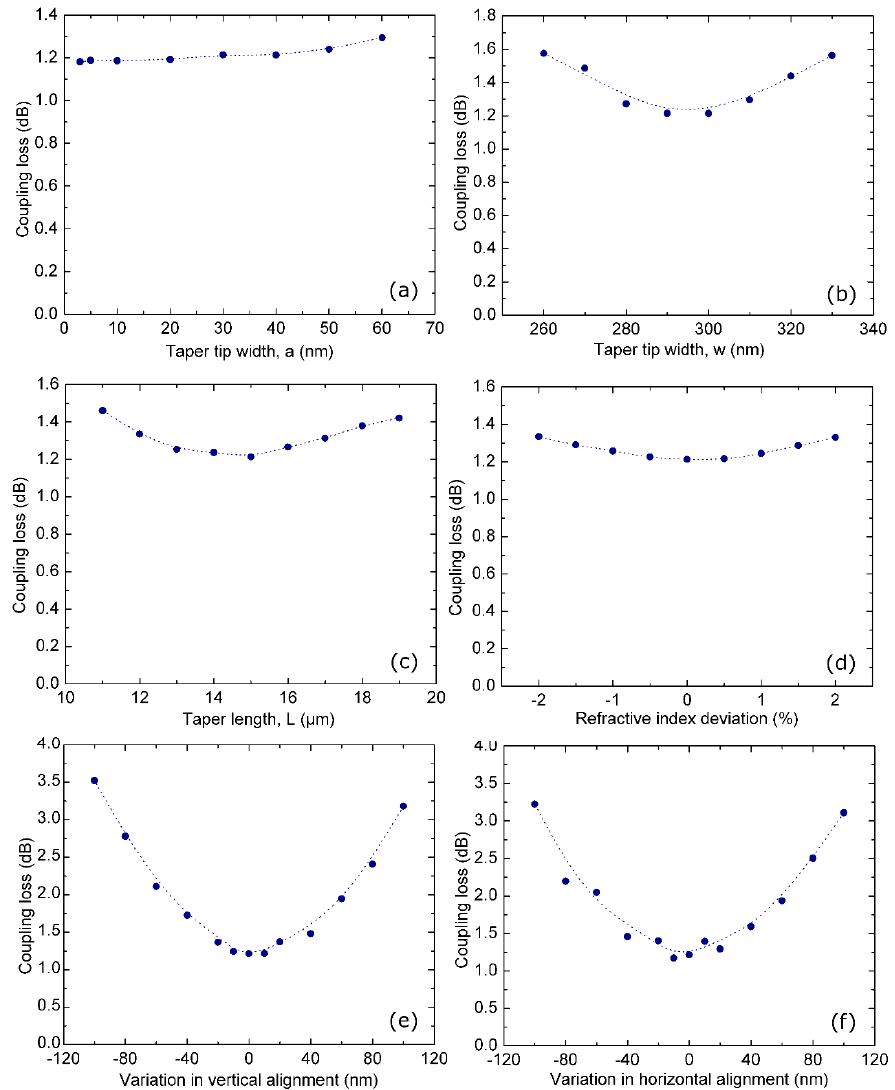
Figure 2. Optical coupling variation with respect to ( a ) taper tip width, ( b ) taper end width, ( c ) taper length, ( d ) amorphous Ge 0.83 Si 0.17 refractive index, and the relative ( e ) vertical and ( f ) horizontal positions between the taper and the Ge-based FKE optical modulator.